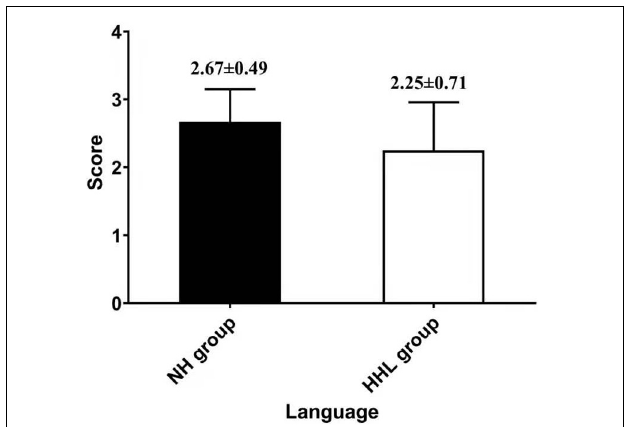
FIGURE 1 | Differences in language ability between the HHL and NH groups.